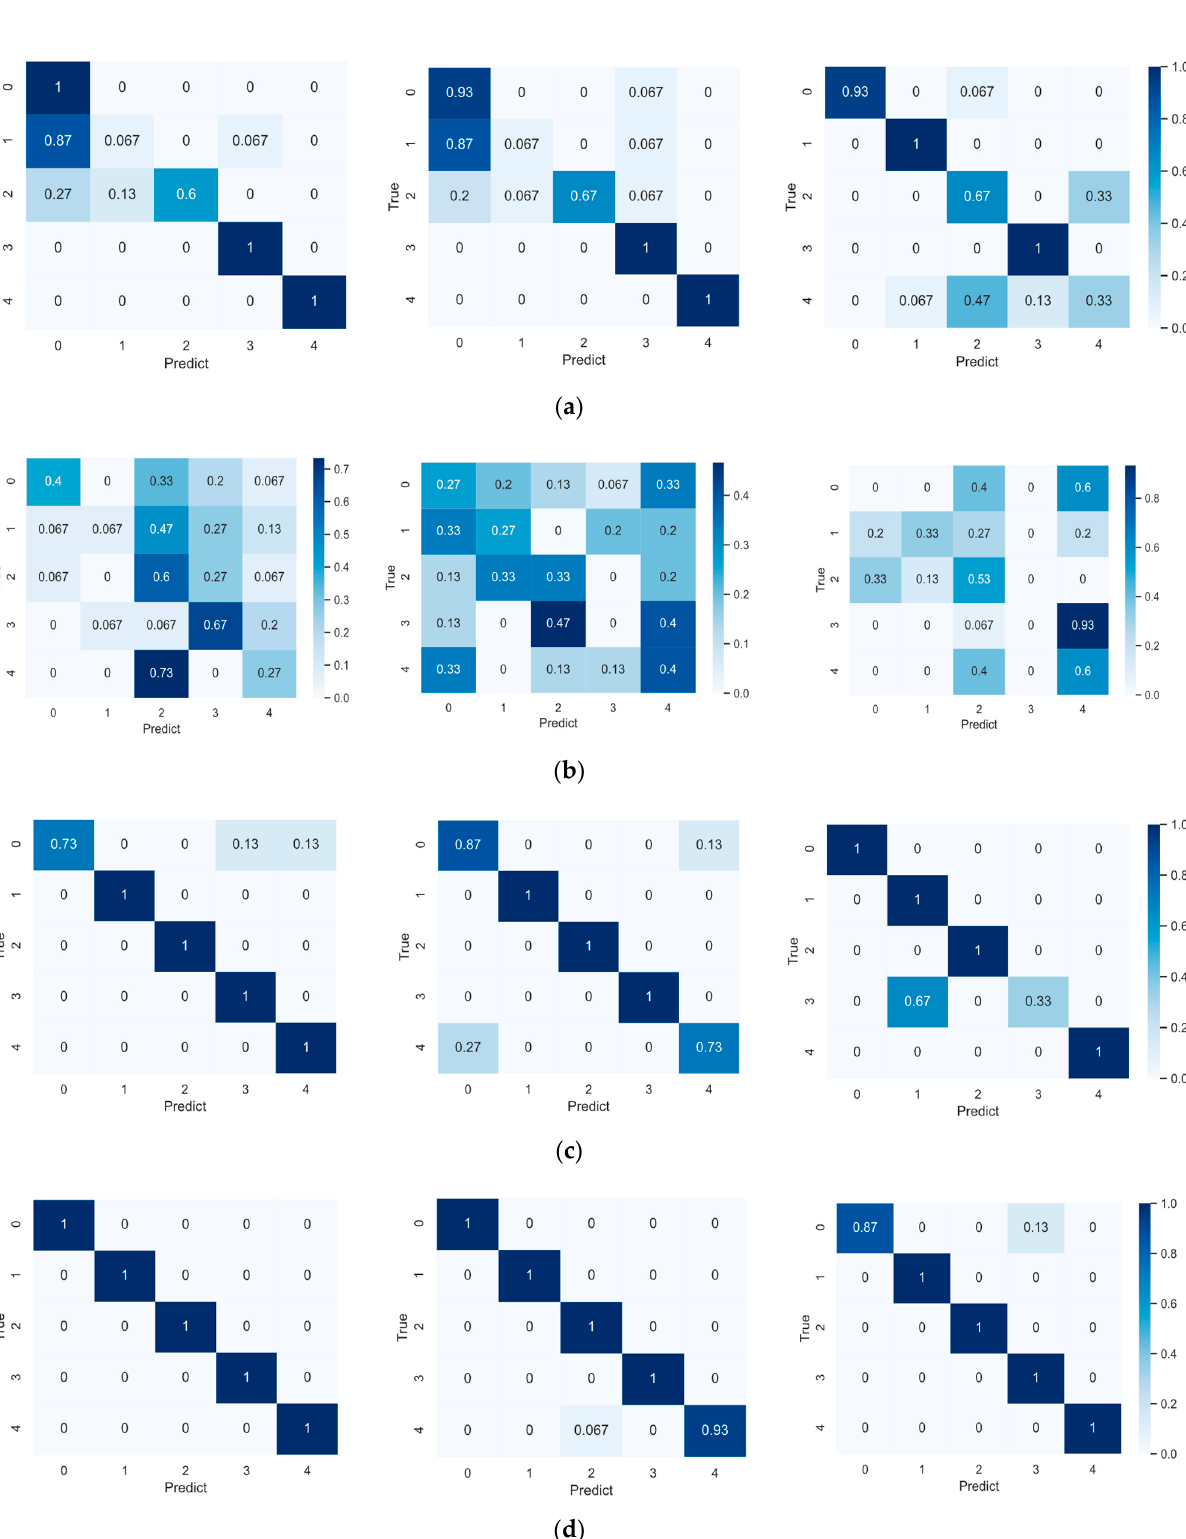
Figure 12. Confusion matrix of several models mentioned in the paper (each model is repeated 3 times) ( a ) Support Vector Machine (SVM); ( b ) Deep Convolutional Neural Networks with Wide First-layer Kernels (WDCNN); ( c ) Pro net; ( d ) the wavelet-prototypical network based on fusion of time and frequency domain (WPNF).